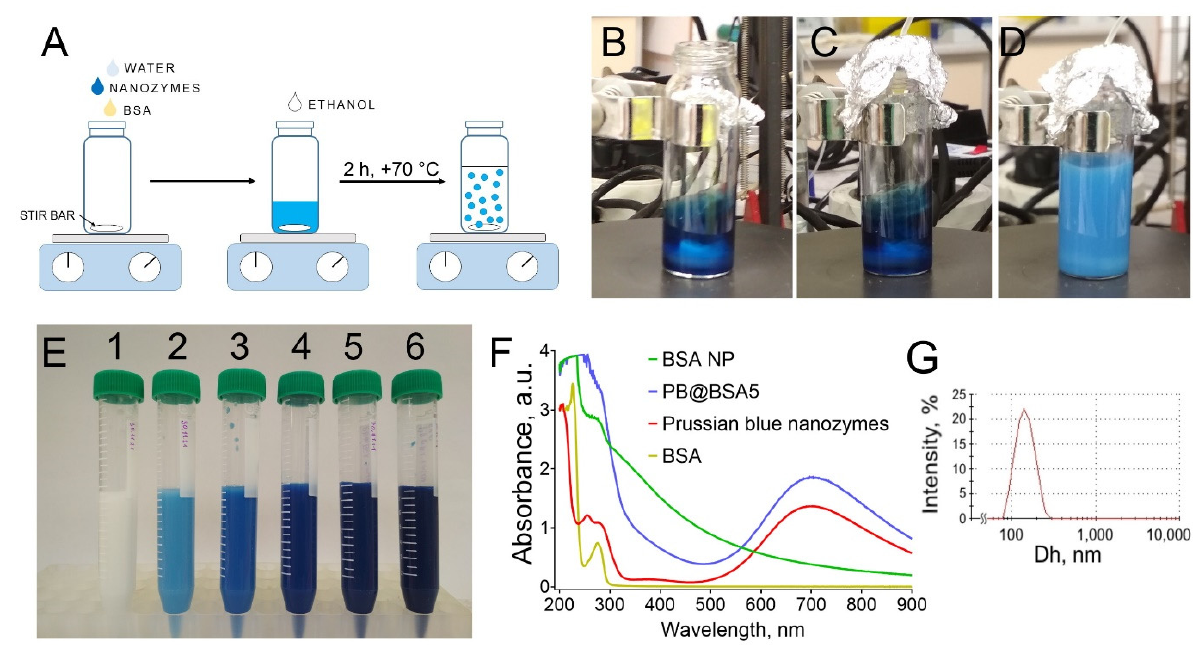
Figure 1. ( A ) Scheme of nanoparticle synthesis; ( B – D ) different stages of PB@BSA1 synthesis: a mixture of BSA and nanozymes before ( B ) and after the addition of 1 ( C ) or 4 ( D ) mL of ethanol; ( E ) nanoparticle suspensions: 1—BSA NPs, 2—PB@BSA1, 3—PB@BSA2, 4—PB@BSA3, 5—PB@BSA4,